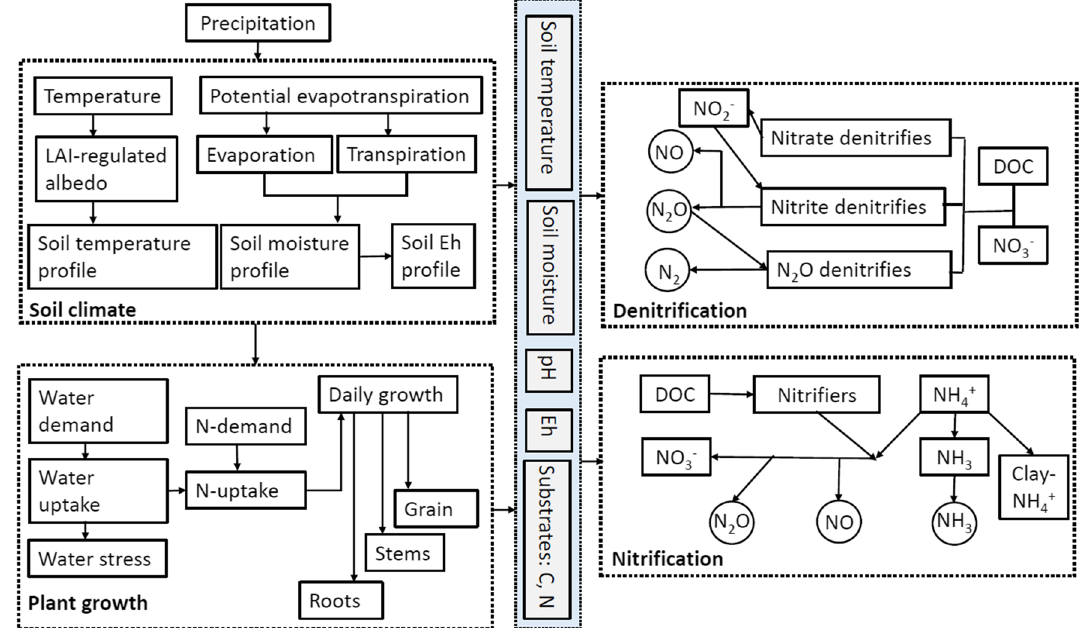
Fig. 1 The impacts of precipitation on plant growth and soil N 2 O emission through denitrification and nitrification processes in the DNDC